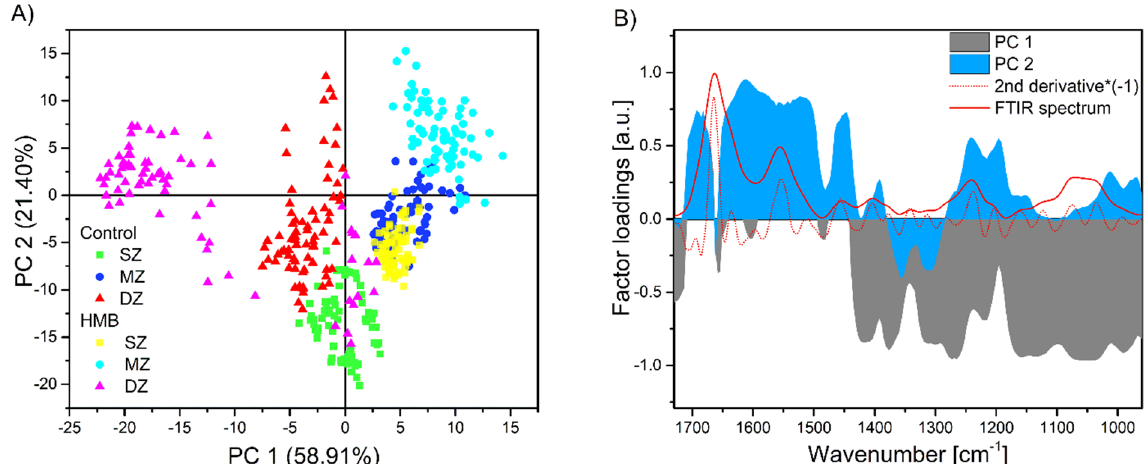
Figure 4. PCA score ( A ) and factor loading ( B ) plots of the first and the second principal components based on the infrared spectra of articular cartilages (AC) samples from the control and HMB-supplemented group in the region of 1730–960 cm − 1 . In ( B ), a solid red line corresponding to a typical FTIR spectrum and a dotted line to its second derivative (multiplied by − 1) revealed the mid-infrared regions covered by factor loadings. HMB–supplemented group, SZ–superficial zone, MZ–middle zone, DZ–deep zone.